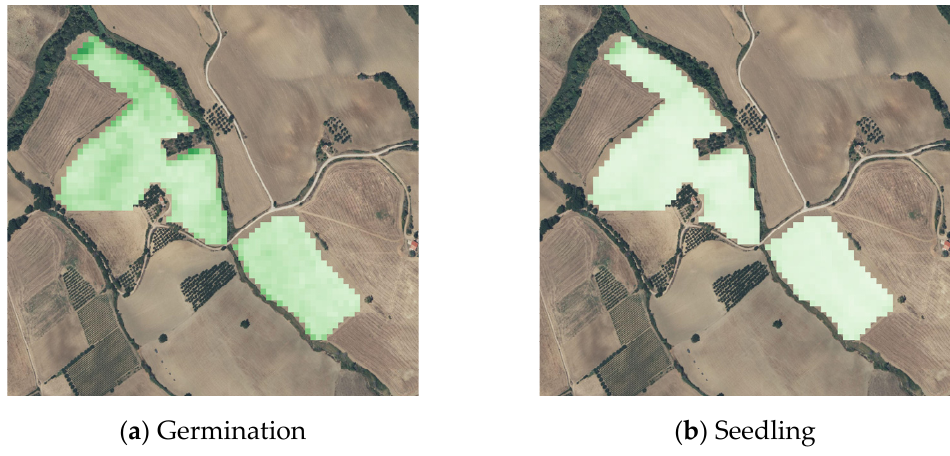
Figure 5. NDVI maps (0–1) derived from the Sentinel-2 images at ( a ) germination, ( b ) seedling, ( c ) tillering, ( d ) booting, ( e ) flowering, and ( f ) milk development Zadok’s stages.